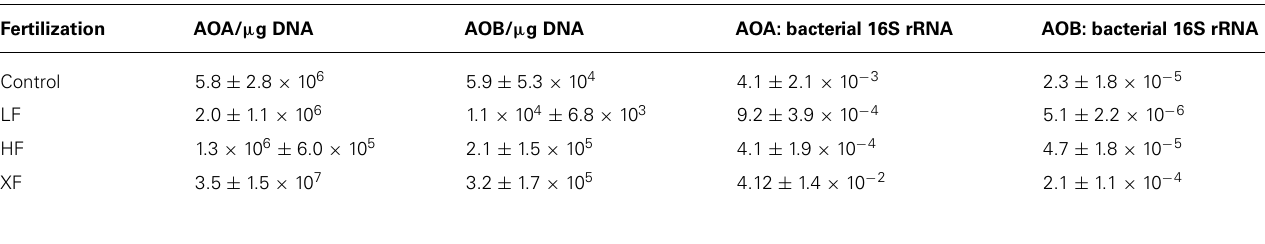
Table 2 | Mean ( ± SE) betaproteobacterial (AOB) and archaeal amo A (AOA) gene abundances presented as gene copies per μ g DNA or normalized to copies of bacterial 16S rRNA genes in plots receiving different levels of fertilization.